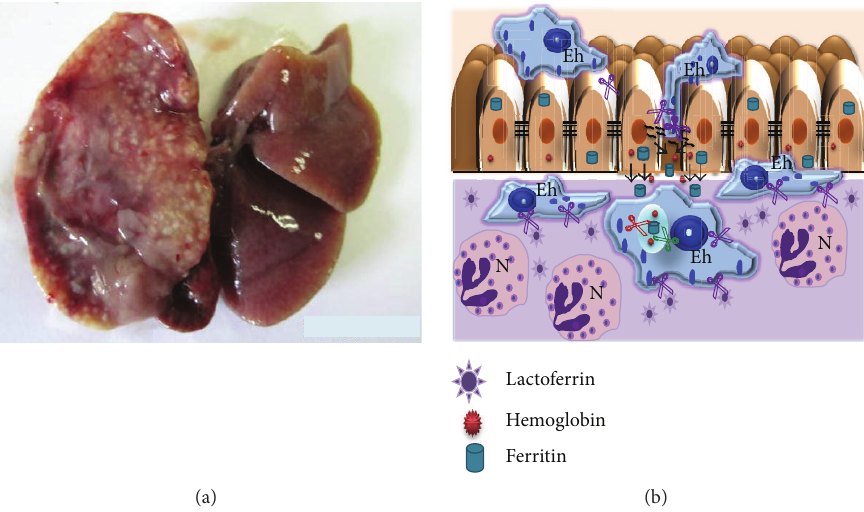
Figure 3: (a) Hamster amoebic liver abscess of eight days of infection (Photo kindly donated by G. Dominguez). (b) Proteases involved in the development of human amoebic liver